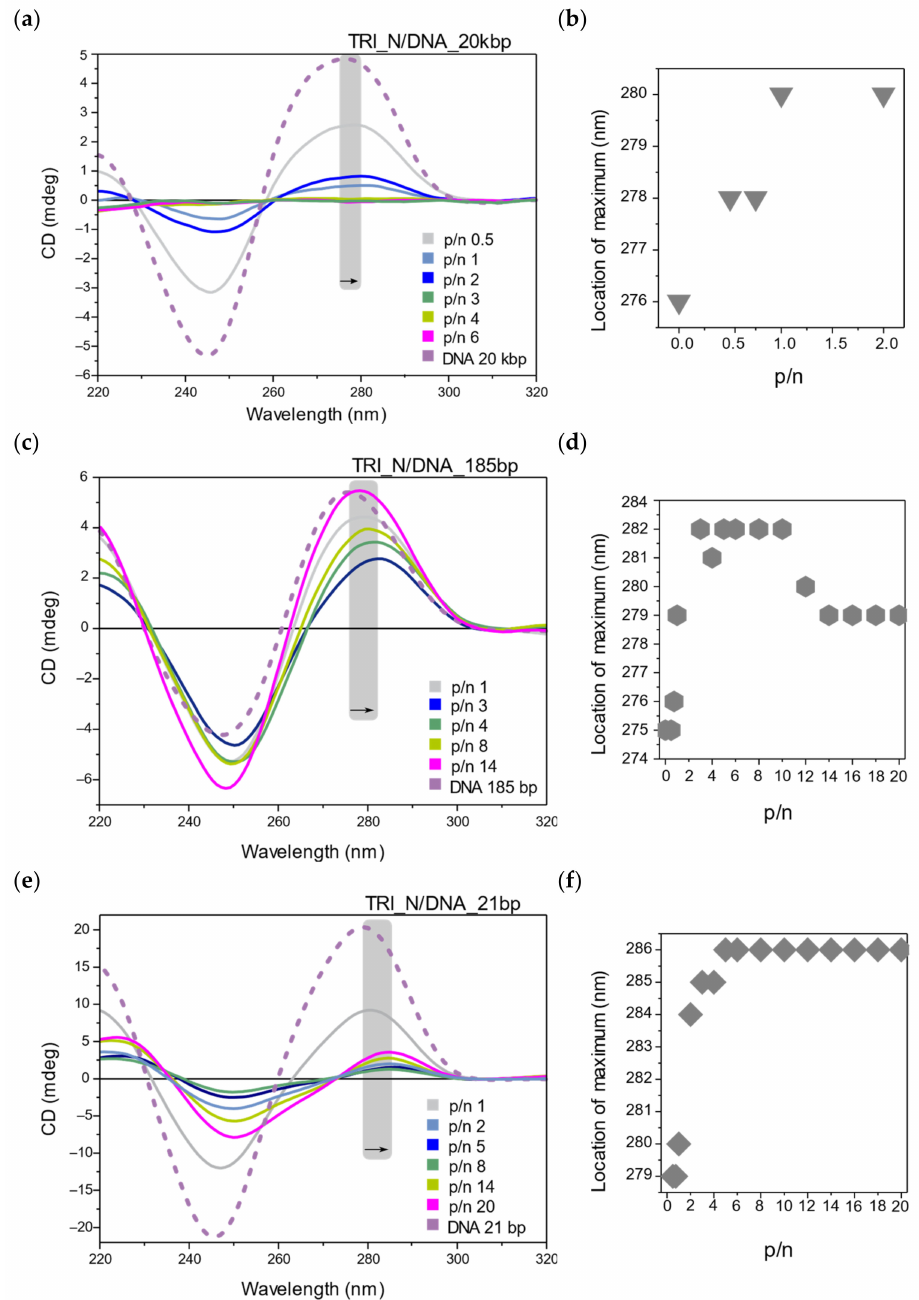
Figure 5. Circular dichroism studies of TRI_N surfactant with different DNAs. ( a ) CD spectra collected for TRI_N/DNA_20kbp systems and ( b ) corresponding shifts of positive maximum with increasing p/n ratio. ( c ) CD spectra collected for TRI_N/DNA_185bp systems and ( d ) corresponding shifts of positive maximum with increasing p/n ratio. ( e ) CD spec- tra collected for TRI_N/DNA_21bp systems and ( f ) corresponding shifts of positive maximum with increasing p/n